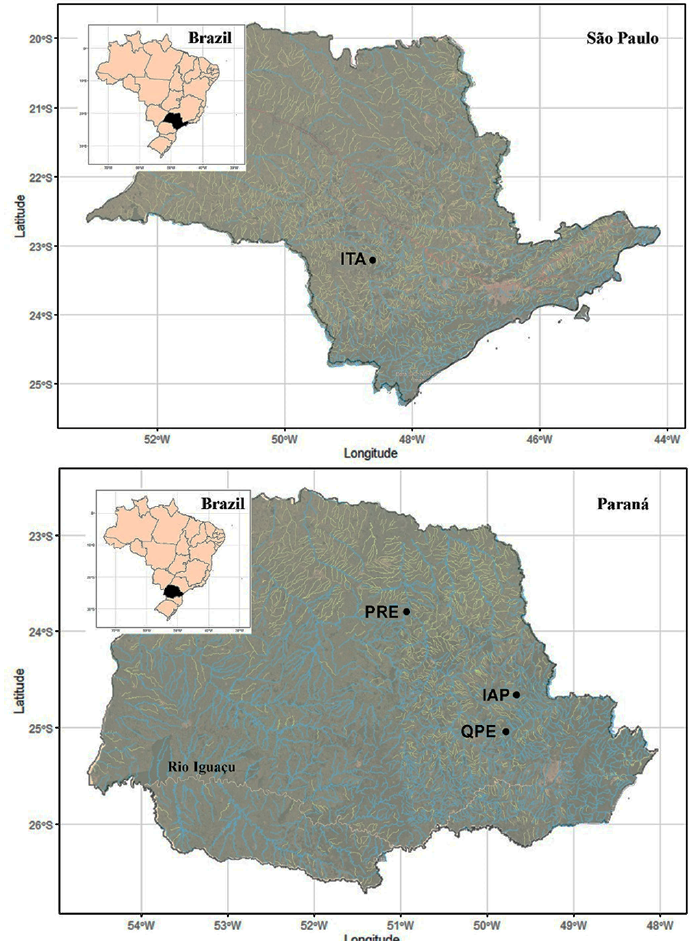
Figure 1. Study sites at Paranapanema sub-basin (São Paulo State): Itaúna stream (ITA) (Itatinga city); and Tibagi sub-basin (Paraná State): Preto stream (PRE) (Mauá da Serra city), Iapó stream (IAP) (Castro city) and Quebra Perna stream (QPE) (Ponta Grossa